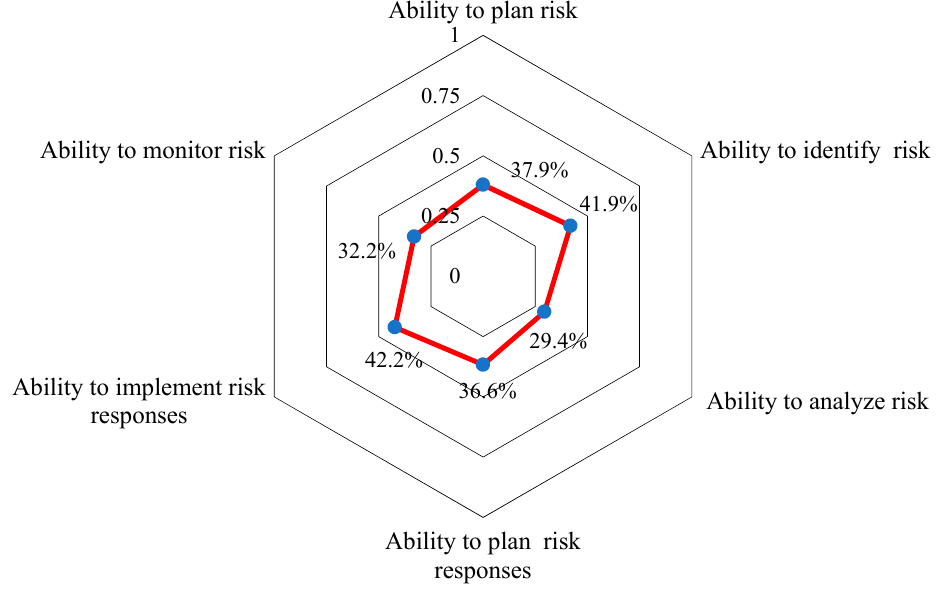
Figure 7. Degree of implementation for each attribute.